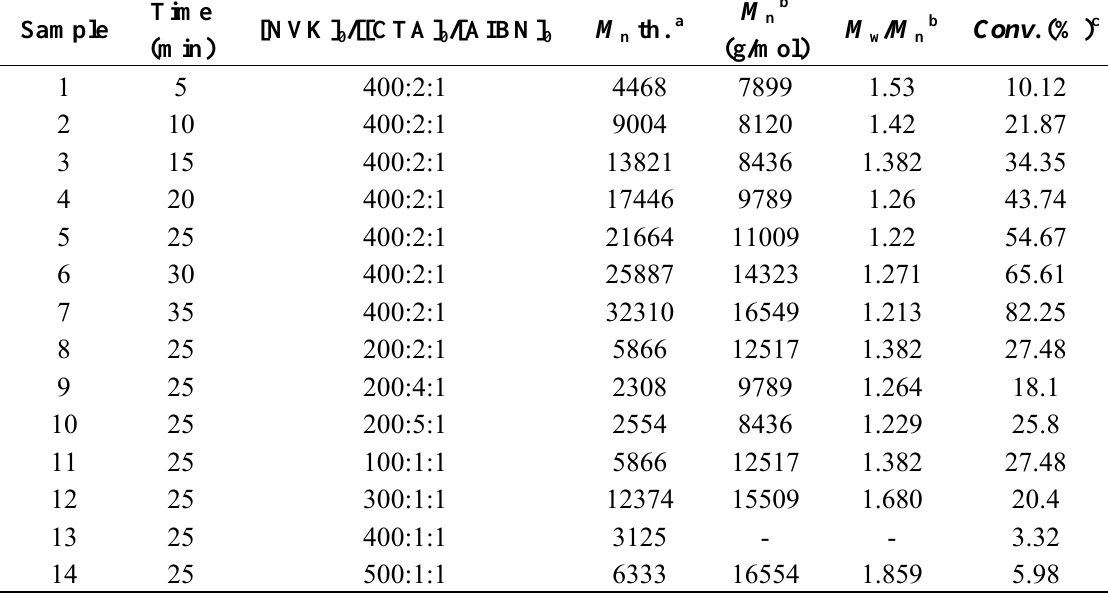
Table 1. Synthesis of three-arm poly( N -vinylcarbazole) (PVK) by microwave-assisted reversible addition-fragmentation chain transfer (RAFT) polymerization of N